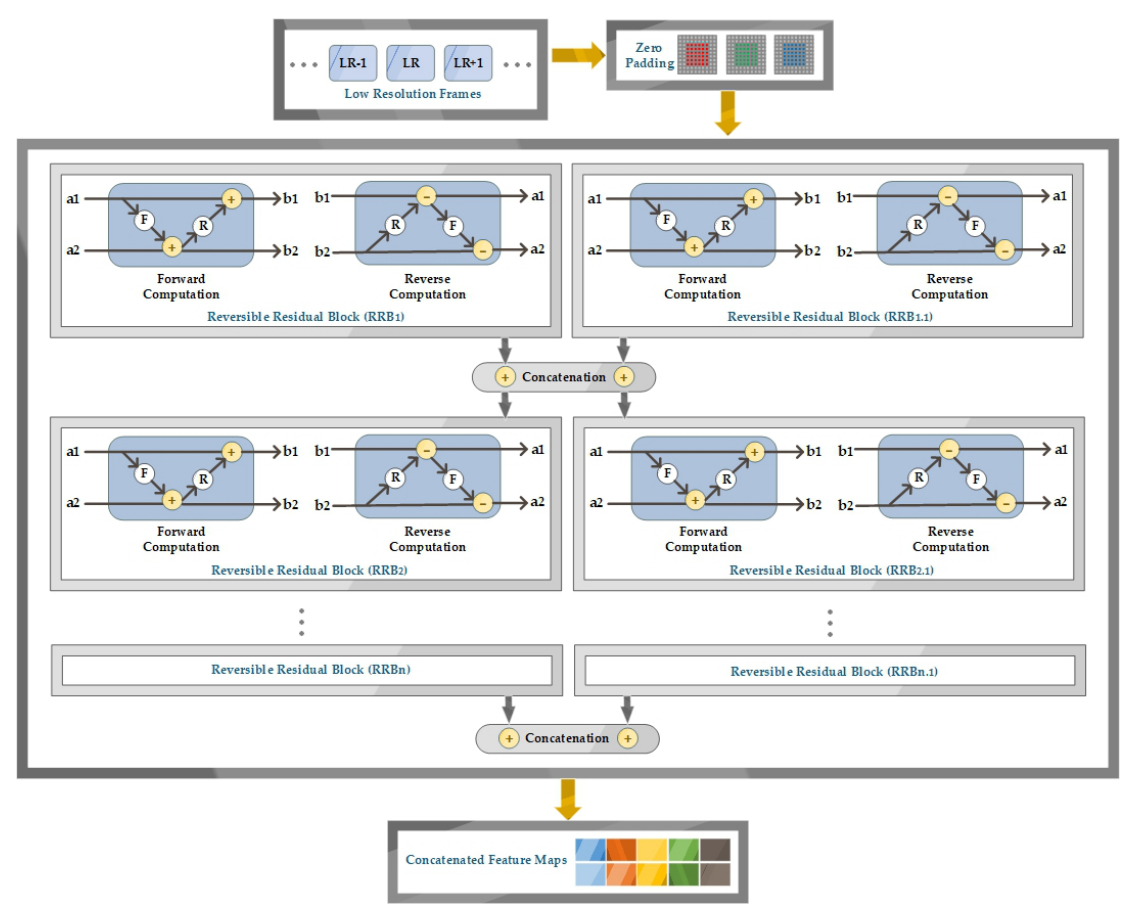
Figure 2. Architecture of the spatial